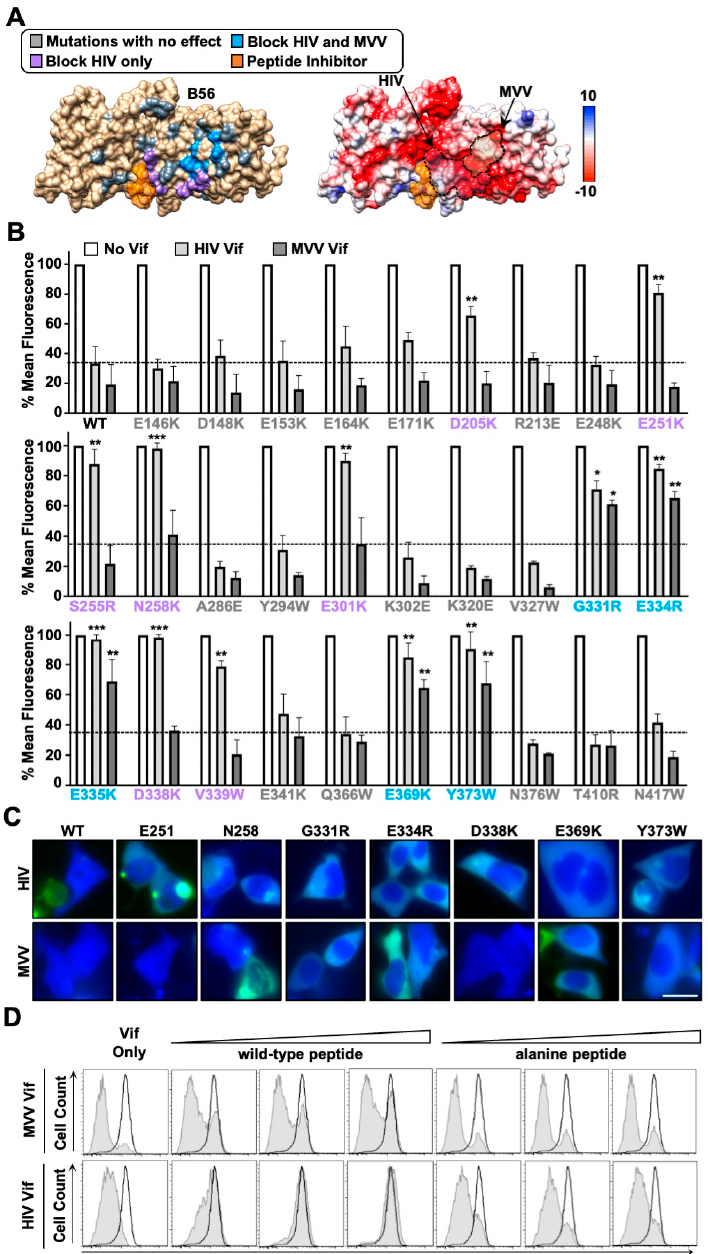
Figure 3. HIV and MVV Vif proteins partially distinct negatively charged B56 surfaces. ( A ) Left, surface depiction of B56 γ (PDB: 2IAE) with residues required or dispensable for Vif degradation highlighted in the indicated color. Grey, no impact to degradation; purple, inhibit HIV Vif-induced degradation; blue, inhibit both HIV and MVV Vif-induced degradation; orange, peptide inhibitor binding site. Right, electrostatic surface potential map with red indicating negative charge, white indicating neutral charge, and blue indicating positive charge. Vif binding surfaces depicted by dashed lines ( B ) Quantification of eGFP mean fluorescence intensity from eGFP-B56 α cells expressing the indicated Vif proteins. No statistical value indicates no significant difference between respective wild-type and mutant Vif proteins; * is p < 0.05; ** is p < 0.01; *** is p < 0.001 by an unpaired student’s t -test. ( C ) Fluorescence microscopy images of HEK293T cells transiently expressing the indicated Vif proteins and B56 α proteins; scale bar is 10 µ M ( D ) Flow cytometry histograms were generated as described in Figure 1. Cells were co-transfected with the indicated Vif protein with either wild- type (LxxIxE) or alanine mutant (AxxAxA) B56 inhibitor peptide constructs. All experiments were repeated at least three independent